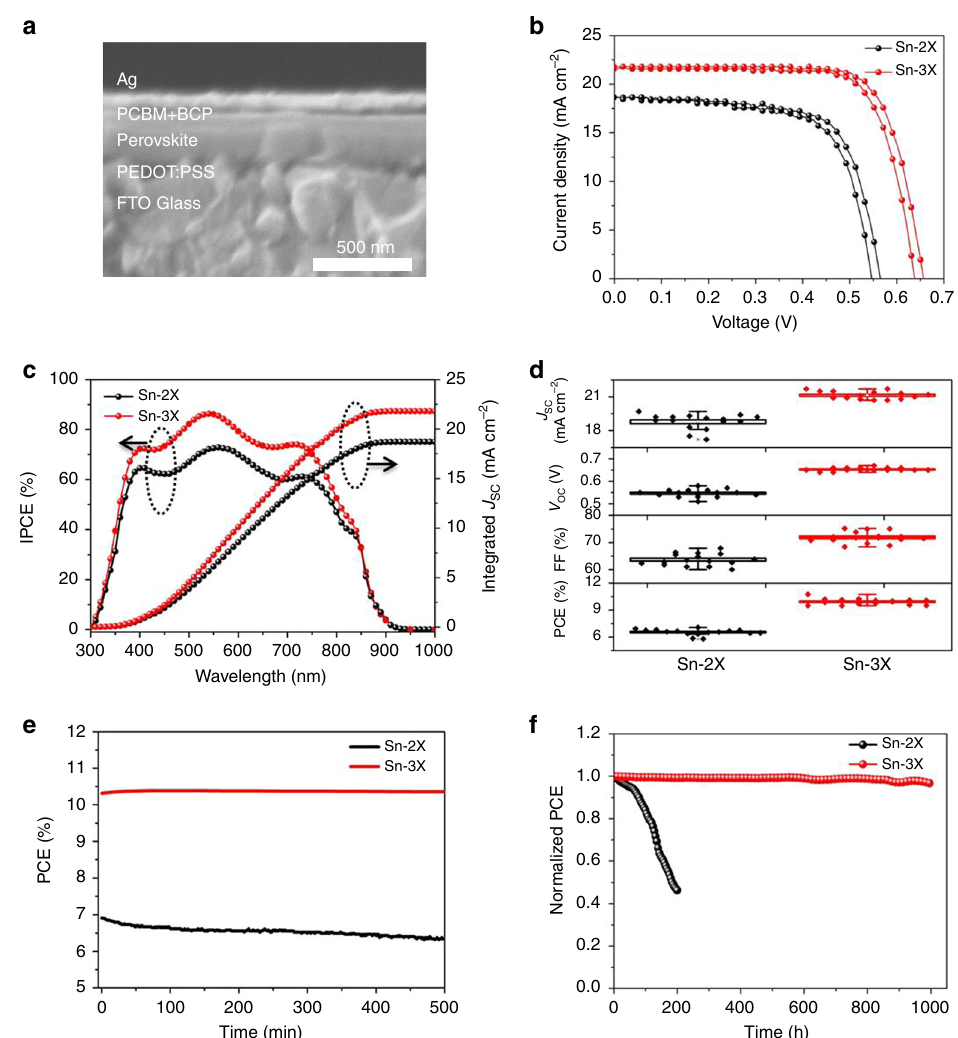
Fig. 3 Con fi guration and device performance of TPSCs. a Cross-section SEM image of the cell based on amorphous-polycrystalline structure. b The I – V curves of Sn-2X and Sn-3X-based TPSCs. c The IPCE of the corresponding devices. d The statistical box chart of the parameters of corresponding devices and 16 cells were fabricated for each type. e The stabilized output of the corresponding devices for 500 min. f The stability test under simulated AM 1.5 G (100 mW cm − 2 ) at the maximum power point. All the cells were encapsulated in N 2 gas